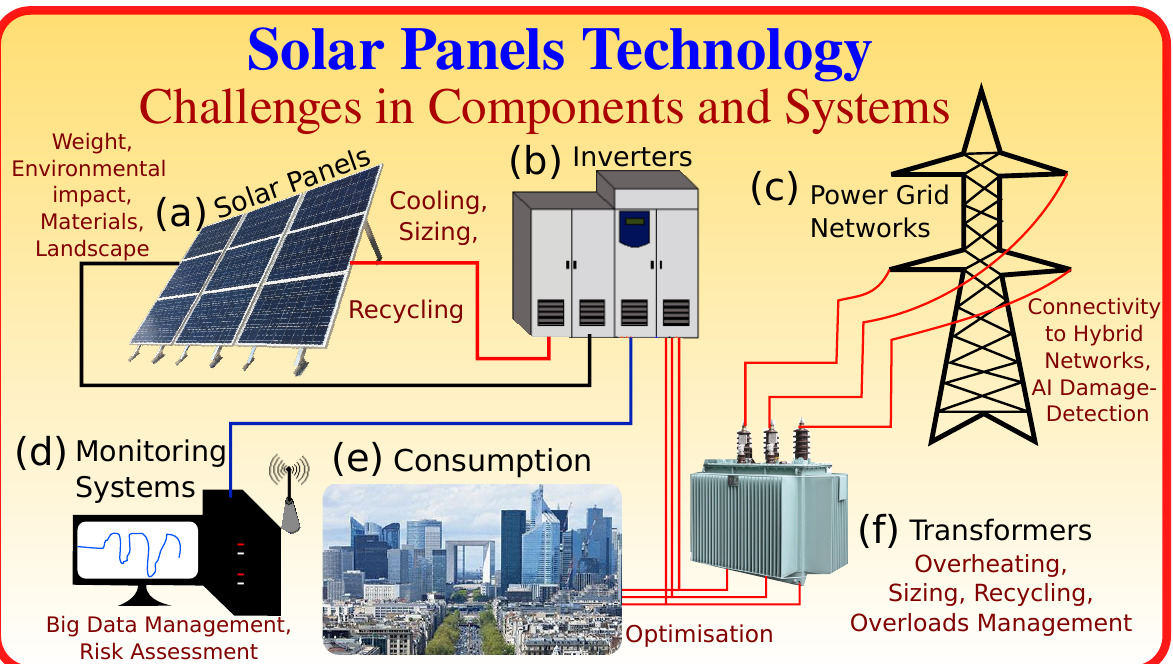
Figure 3. Major challenges in solar panels’ technology. This includes optimal orientation of solar panels, aerodynamic stress reduction to violent wind, cooling of solar cells for enhanced efficiency, weight reduction, landscape panels optimal distribution, overall materials recycling, optimisation of inverters for enhanced compactness and cooling, hybrid connectivity of power grid networks, consumers consumption optimisation, big data from monitoring systems management and control, resizing and optimal distribution of transformers and AI and ML damage